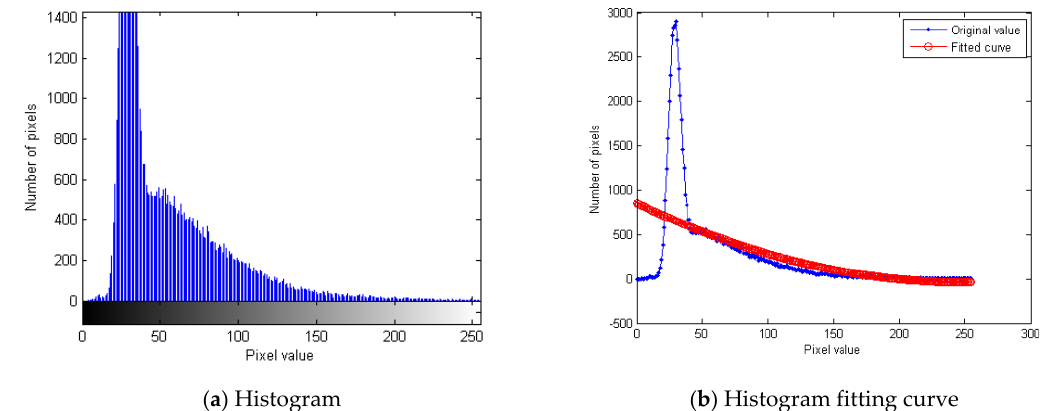
Figure 13. ( a , b ) Histogram and fitting curve of the target image.